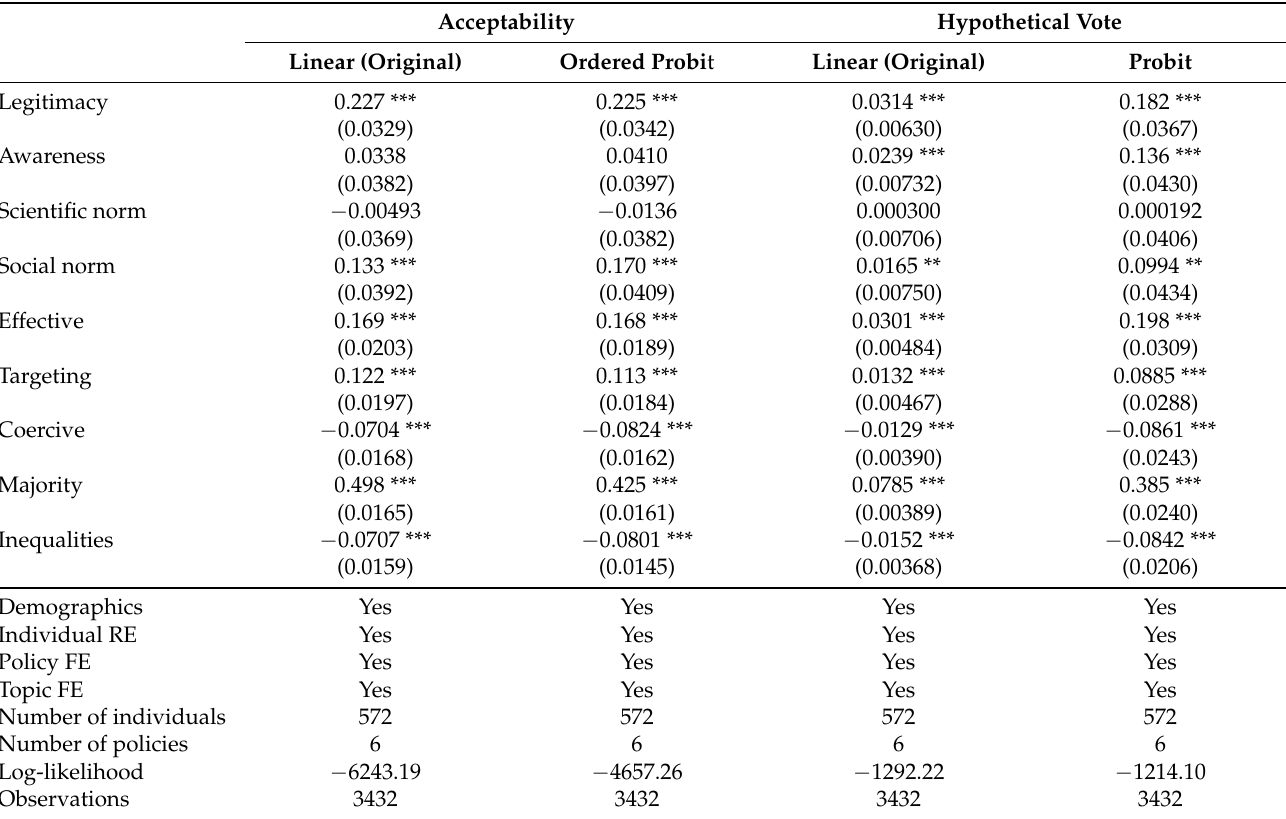
Table A3. Robustness check: linear and non-linear specifications.